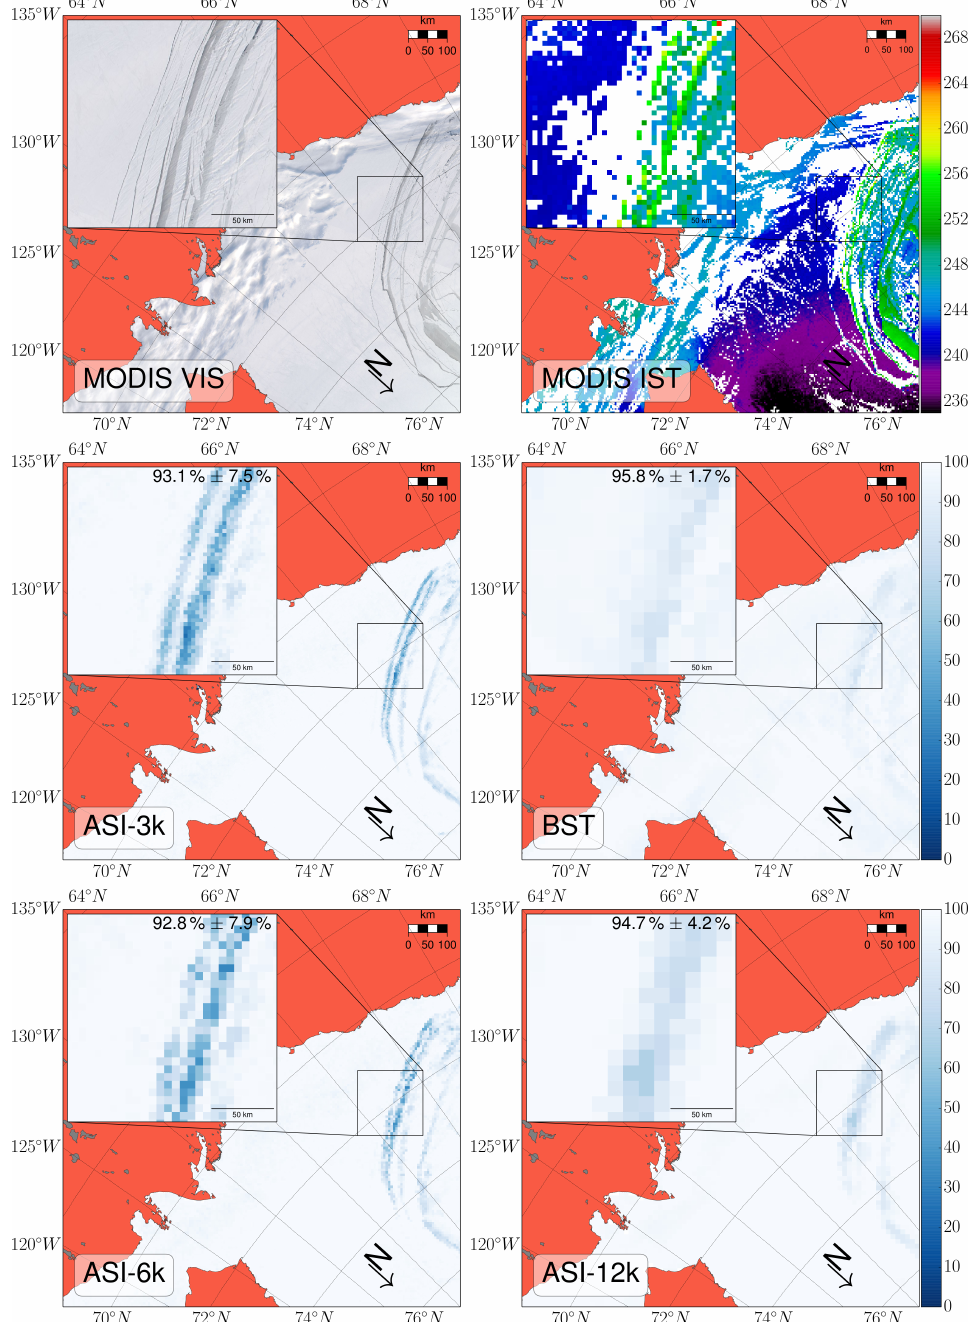
Figure 1. Comparison of 250-m MODIS True Color (MODIS VIS), 4-km MODIS ice surface temperature (MODIS IST), ASI-3k, ASI-6k, ASI-12k and Bootstrap (BST) sea ice concentrations (SIC) for 25 February 2013. All maps display a part of the southern Beaufort Sea, with the Canadian and Alaskan coasts in the upper and left parts of the maps. The northern tip of Banks Island can be seen at the lower margin of the maps. An image inset with a zoom of a specified region (170 km × 170 km ) is placed on the continental areas for a closer examination of the individual data sets. An arrow depicts the direction to the North Pole. The white areas in MODIS IST depict missing